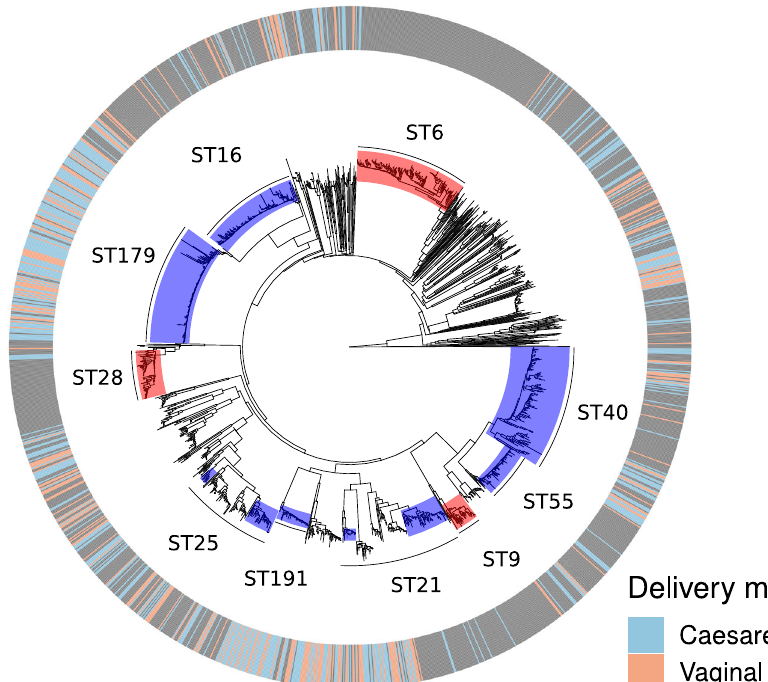
Fig. 7 | Embedding of the neonatal cohorts within a general E. faecalis species- wide collection. Outer metadata blocks depict the delivery mode of the cohorts (caesarean, light blue; vaginal, orange), aligned against the neighbour-joining (NJ)